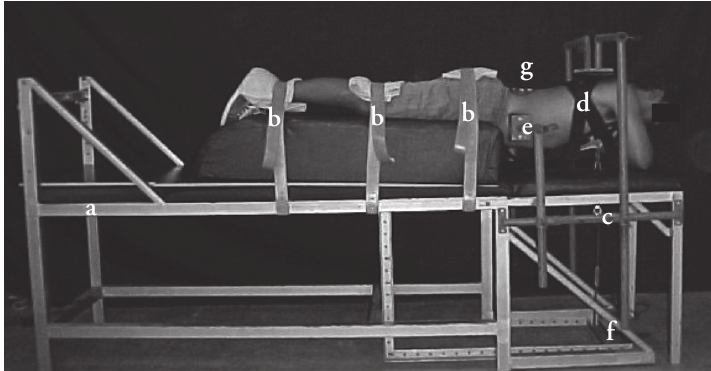
Figura 1 - Postura dos sujeitos e equipamentos utilizados para a CVM e contrações submáximas. a: mesa de testes; b: cintos de couro; c: célula de carga; d: colete; e: limitadores de movi- mento; f: indicador digital; g: Fisioter Mov. 2010 out/dez;23(4):575-83